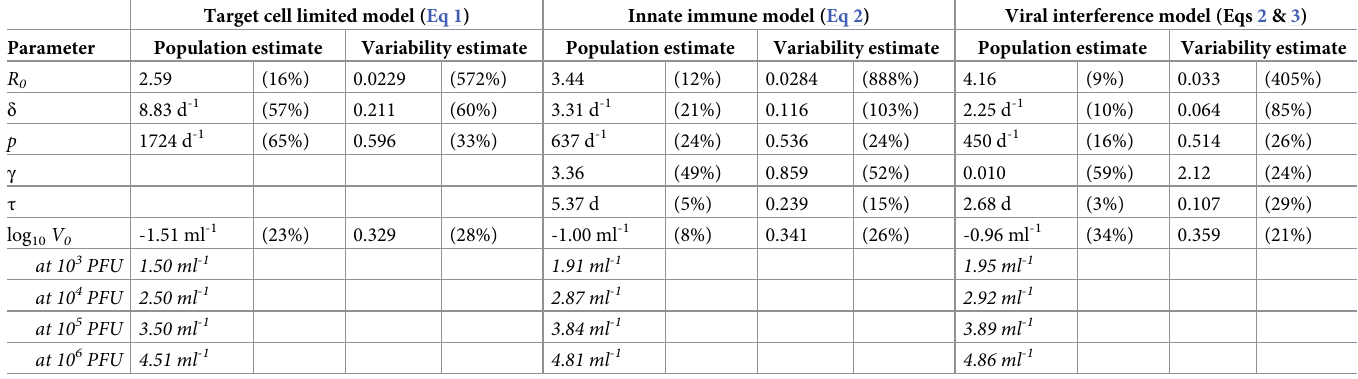
Table 1. Estimated population parameters from fitting the indicated models to viral load data from all animals using a non-linear mixed effects model. An explicit covariate relationship between inoculum dose and initial viral load V 0 is incorporated, with the median population estimate for log 10 V 0 at each inoculum dose shown in italics. Relative standard errors are shown in parentheses. Fixed parameters used in the model fits are: k = 8 d -1 , c = 10 d -1 , s = 1 d -1 , α = 2 d -1 , K = 10 3 , n = 0.25, T (0) = 10 5 ml -1 , each with no